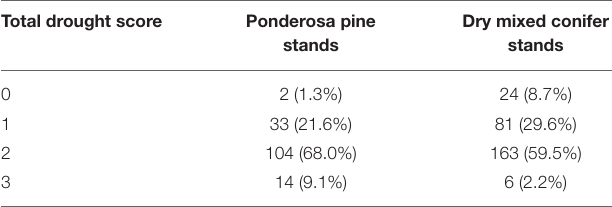
TABLE 5 | Number (and percent) of sampled ponderosa pine and dry mixed conifer stands by drought score on the Rio Tusas-Lower San Antonio landscape calculated with the indicators in Table 1